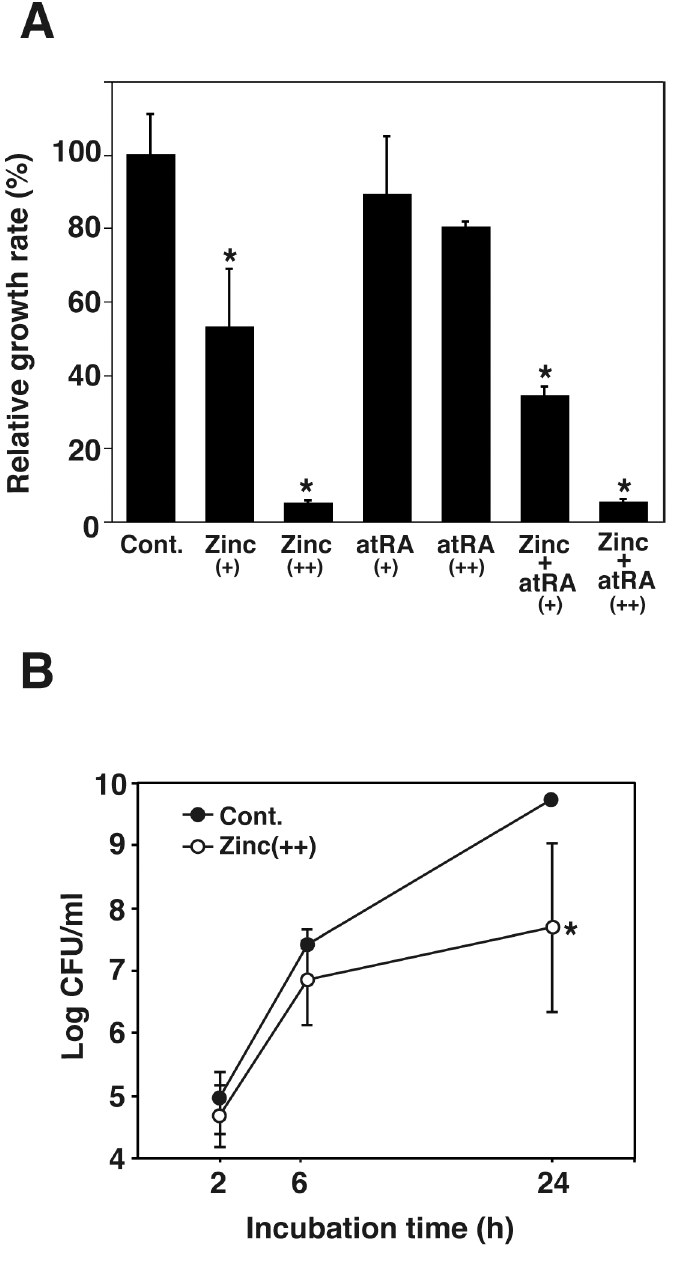
Fig 5. L . monocytogenes growth in vitro in the presence of Zn, atRA or their combination. L . monocytogenes was cultured in BHI broth for 24 h in tubes containing ZnSO 4 (+; 200 or ++; 1,000 μ M) or atRA (+; 10 or ++; 50 μ M) at 37°C. CFU values were determined by serial dilution on BHI plates. For each sample, CFU values of L . monocytogenes observed in the absence of Zn and atRA was set at 100% and CFU values in the presence of Zn and atRA was showed relative to this value. Data are the averages of triplicate samples from three identical experiments and error bars represent SD. Statistically significant differences, compared with the control, are indicated by asterisks. Panel B shows growth curves of bacteria in BHI broth with or without